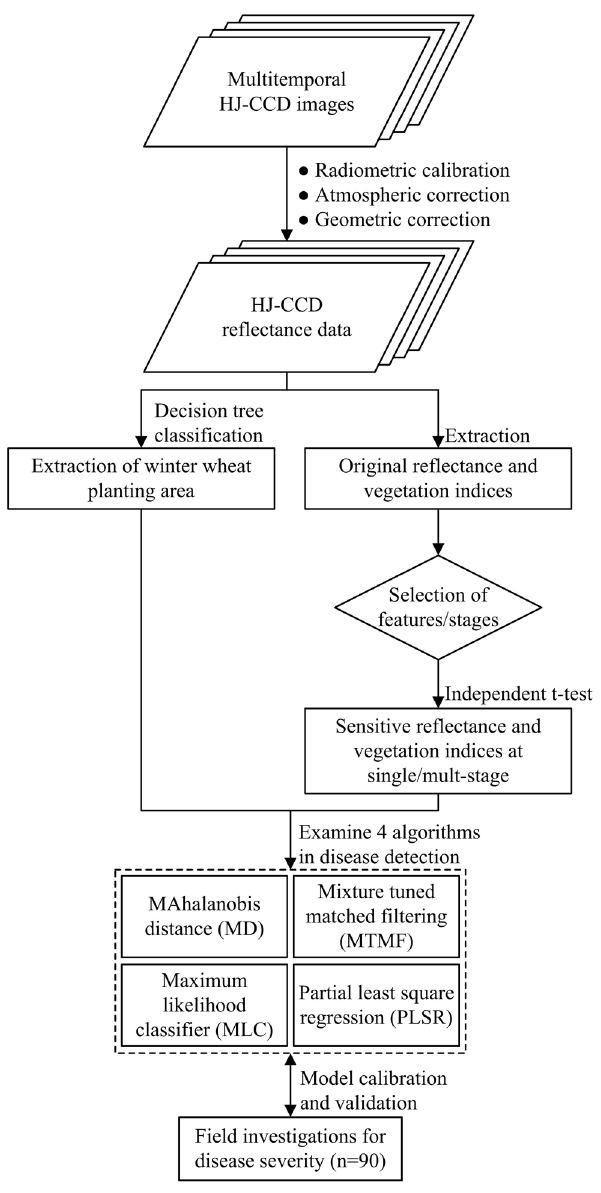
Figure 3. General workflow of mapping powdery mildew at a regional